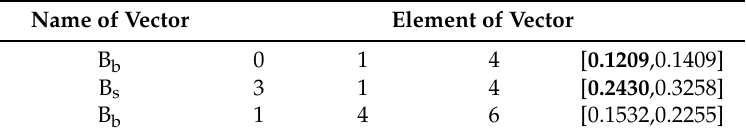
Table 4. Identification template 2 for cropland class.